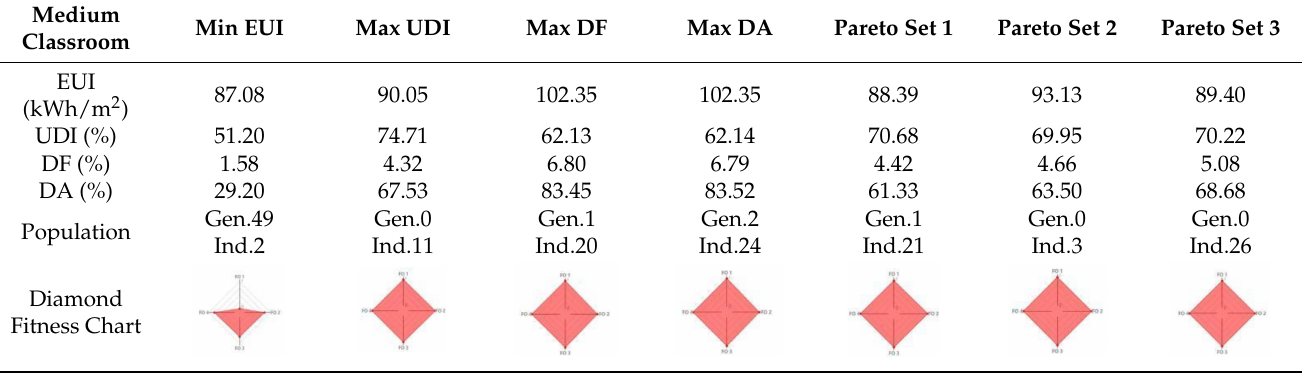
Table 13. The case of medium-sized classrooms with window openings on the east facade.